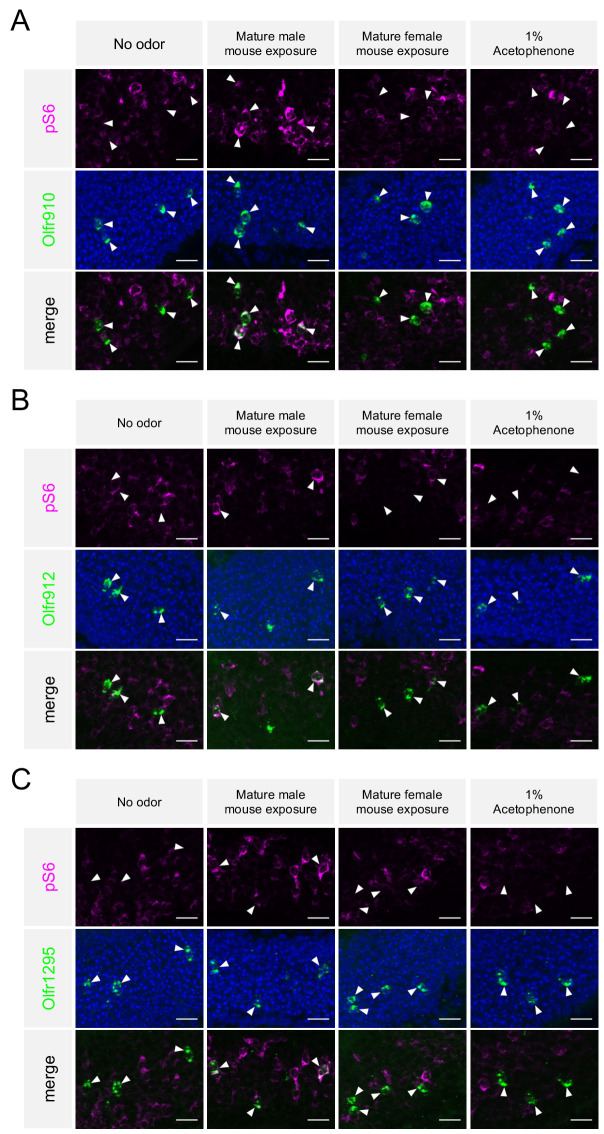
Example in situ stainings showing sexually dimorphic ORs are activated by mature male mouse odor.(A) Representative images showing in situ mRNA hybridizations probing for Olfr910 expression and pS6 immunostainings. Co-localization events are only seen following mature male mouse exposure as indicated by arrowheads. Scale bars indicate 20 μm. (B) Representative images showing in situ mRNA hybridizations probing for Olfr912 expression and pS6 immunostainings. (C) Representative images showing in situ mRNA hybridizations probing for Olfr1295 expression and pS6 immunostainings.